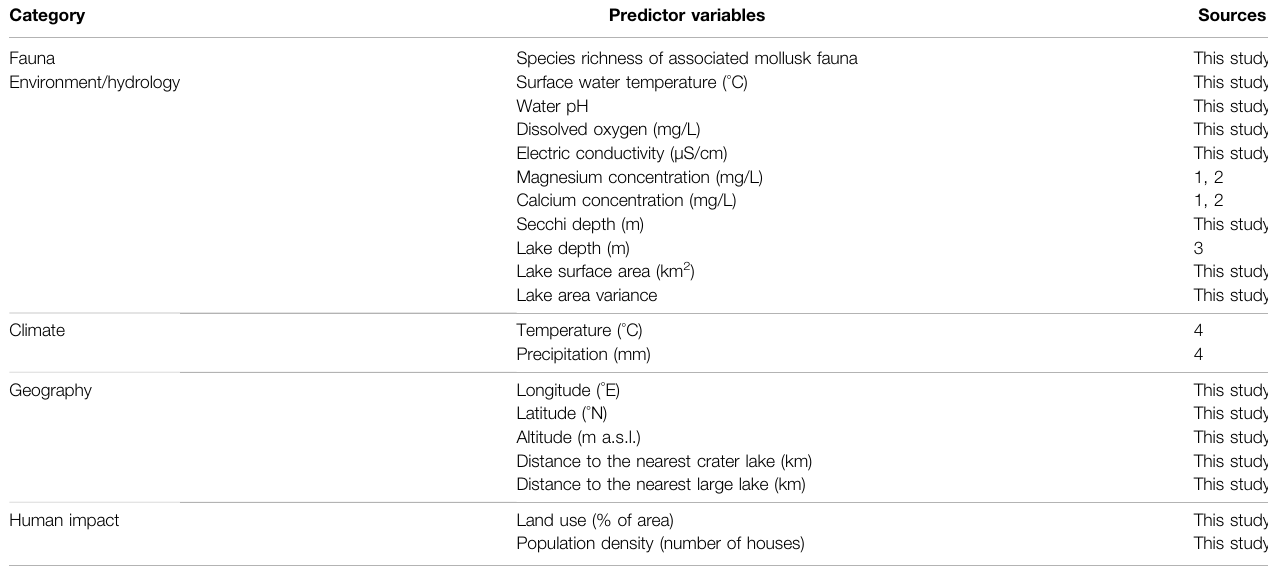
TABLE 1 | Predictor variables used in this study. Note that temperature and precipitation each represent the fi rst principal component calculated from three climate parameters; see text for details. Sources: 1 — Rumes et al. (2011), 2 — Nankabirwa et al. (2019), 3 — De Crop and Verschuren (2019), 4 — Fick and Hijmans